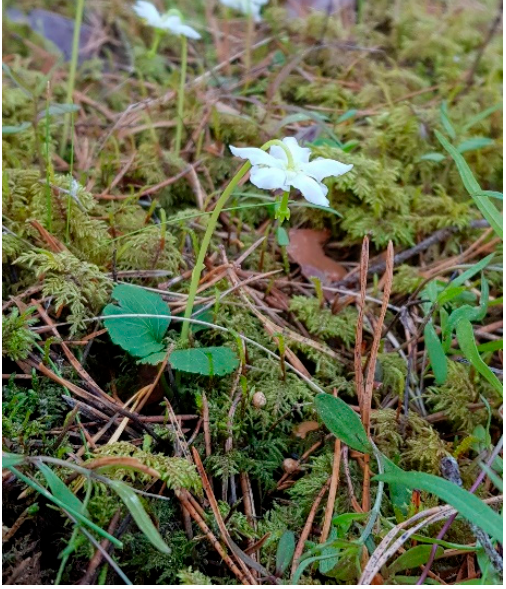
Figure 4. Moneses uniflora , a species favored by historical human use of boreo-nemoral forests, mainly livestock grazing. (Photo: the author, June 2022).